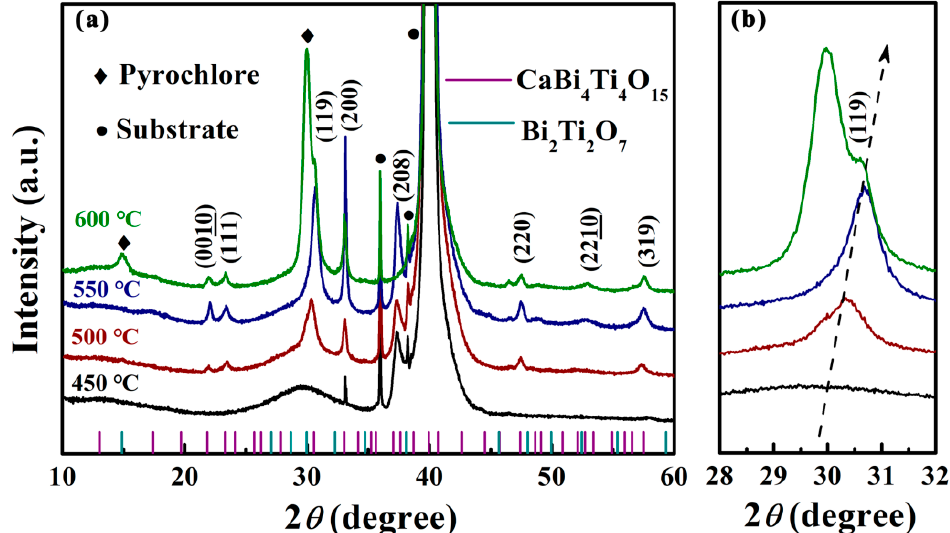
Figure 1. ( a ) X-ray diffraction (XRD) patterns in the 2 θ range of 10–60 ◦ of the CBTi-BFO films annealed at various temperatures. ( b ) Enlarged XRD patterns of the diffraction peaks of 2 θ at around 30 ◦.